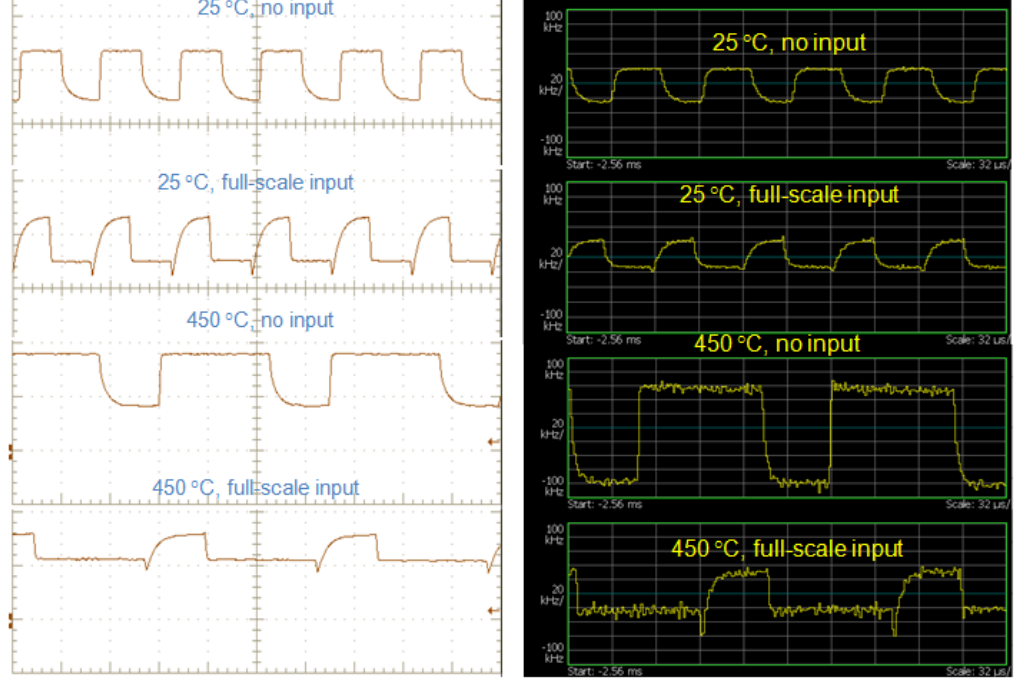
Figure 17. The blue solid line represents the frequency of the demodulated square waveform, while the green dash-dotted line and red dashed line are the amplitude of the demodulated waveform